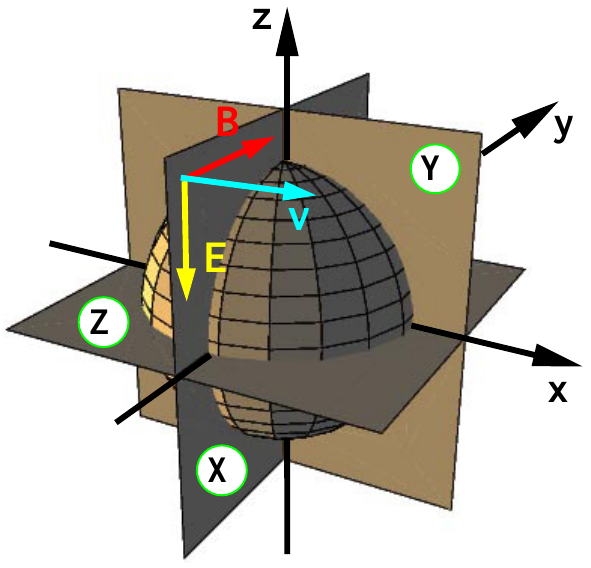
Fig. 3. Cross sections of the simulation box at the plane x = 0, y = 0 and z = 0 presented in Sect.